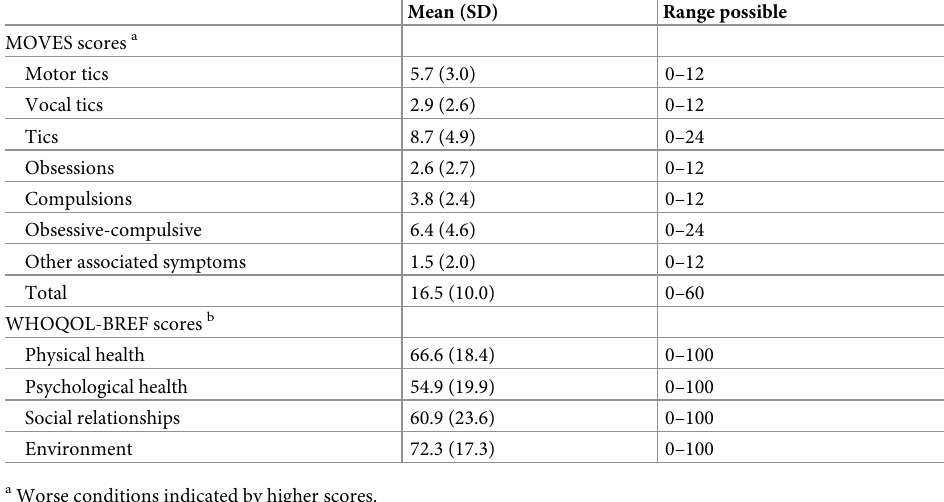
Table 2. Severity of tics (MOVES questionnaire) and health-related quality of life assessed by a generic question- naire